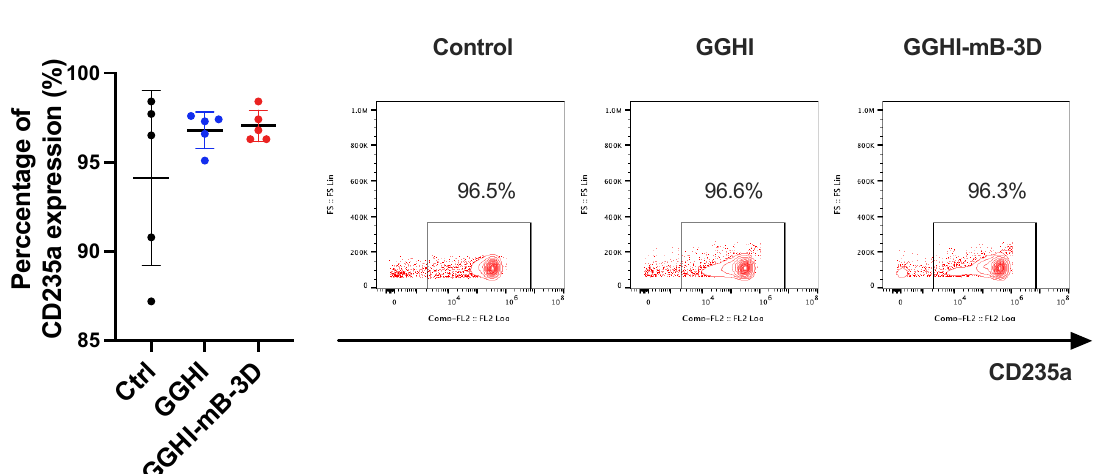
Figure 2. Increased production of F-cells in β S β S SCD CD34 + cells: ( A ) Before-and-after plot showing F-cell percentages before and after transduction of β S β + SCD CD34 + cells with GGHI ( p = 0.746, n =